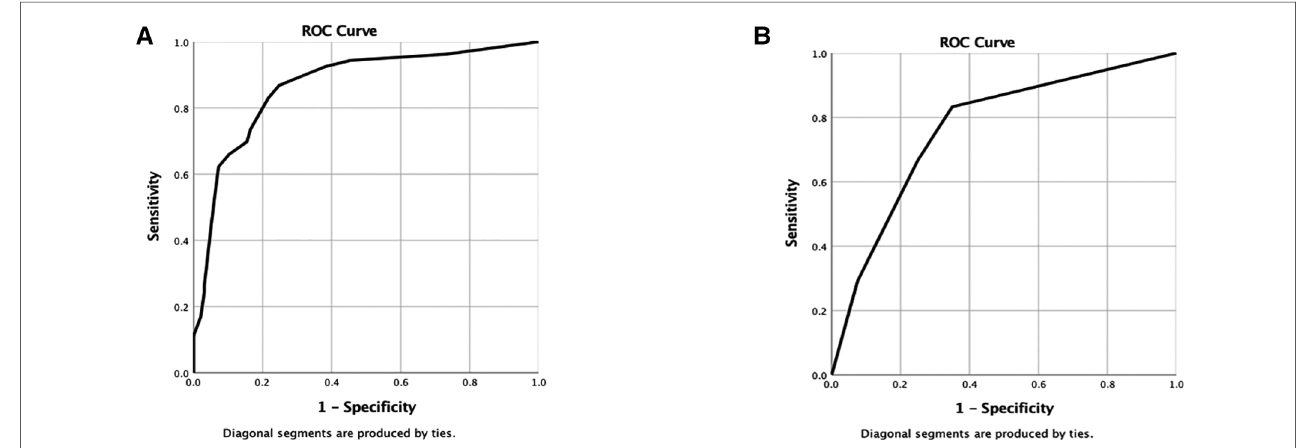
FIGURE 5 ( A,B ) Are the ROC curves of nomogram of modeling group and veri fi cation group respectively.